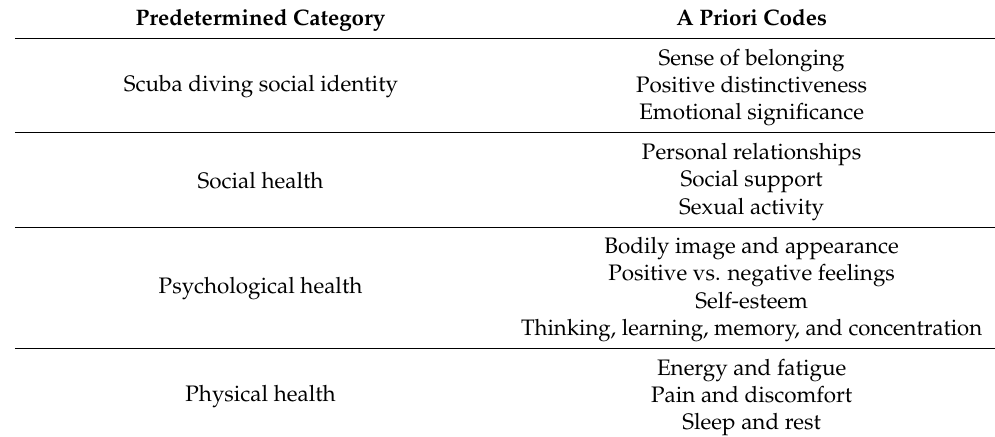
Table 1. The qualitative analysis of a priori